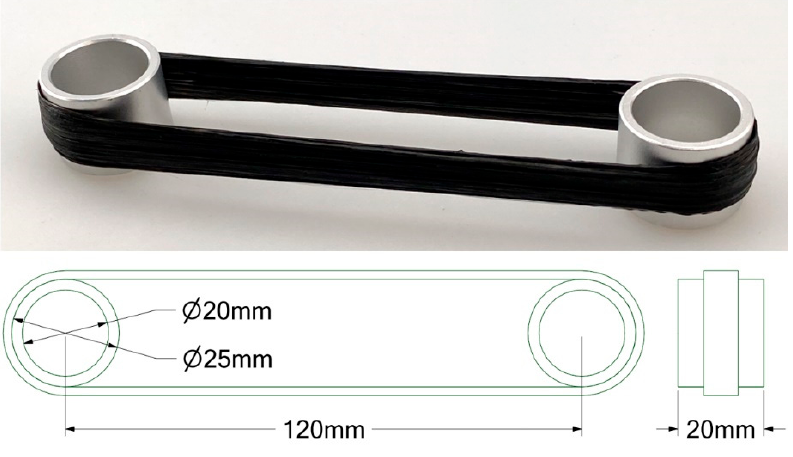
Figure 2. Simple loop specimen with dimensions, adapted from [21].